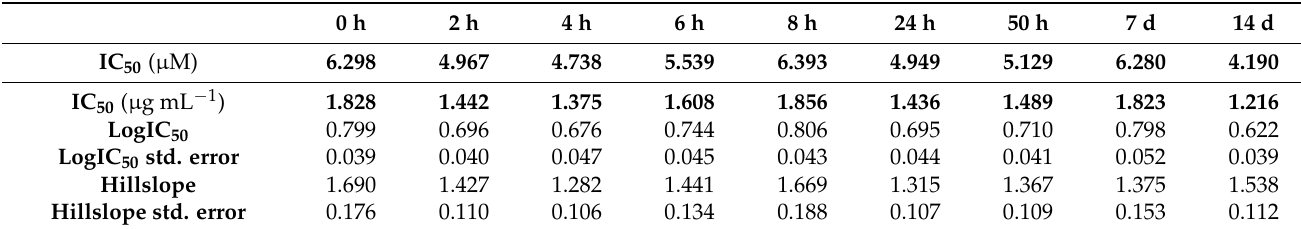
Figure 10. Logarithmic curves plotting the DPPH scavenging effect (%) of ( − )-epicatechin against the concentration, measured over time. Table 4. The calculated IC 50 values of the antioxidant activity of ( − )-epicatechin tested in the range of 0.1–1000 µ M or 0.029–290 µ g mL − 1 over